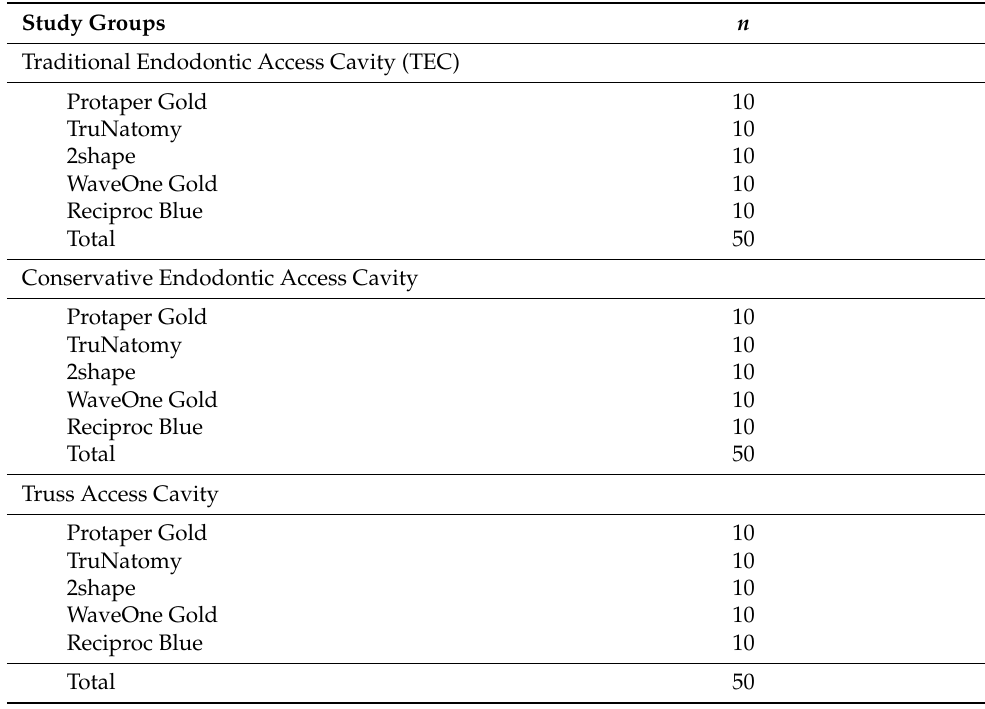
Table 1. Overview of sample size of each experimental